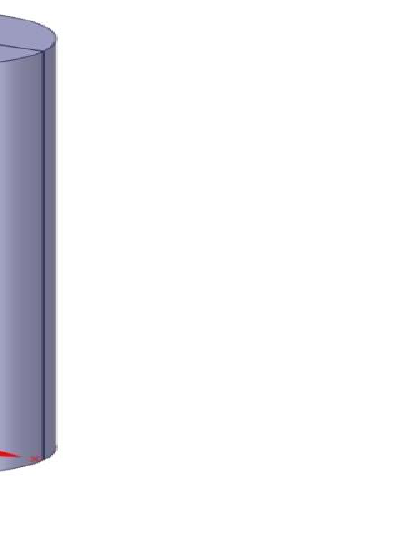
Figure 1. Modelling setup. The aerated mixture can be divided into three layers: the foam layer, the gas-liquid mixing layer, and the liquid layer. ( a ) Three-Dimensional Model. ( b ) xy -Plane Slice. To investigate the separation process of the liquid from the gas-liquid-foam mix- ture numerically, the population balance model [32,33] is adopted, where the distribution of the foam diameter is a key parameter. In the present study, twelve foam classes are adopted, which cover the typical foam diameters. Figure 2 shows the distribution of the foam diameter. The minimum foam diameter is 0.5 mm, and the maximum foam diameter is 4 mm. The gas-liquid-foam mixture consists of three phases: gas phase, liq- uid phase, and foam phase. The densities of the gas phase and liquid phase are 3 kg/m 3 and 1200 kg/m 3 , respectively, and the viscosities of the gas phase and liquid phase are 0.0001 Ns/m 2 and 0.04 Ns/m 2 , respectively. The foam is considered as a separate phase comprised of a mixture of gas and liquid, and the density and viscosity of the foam phase are calculated by the following equations